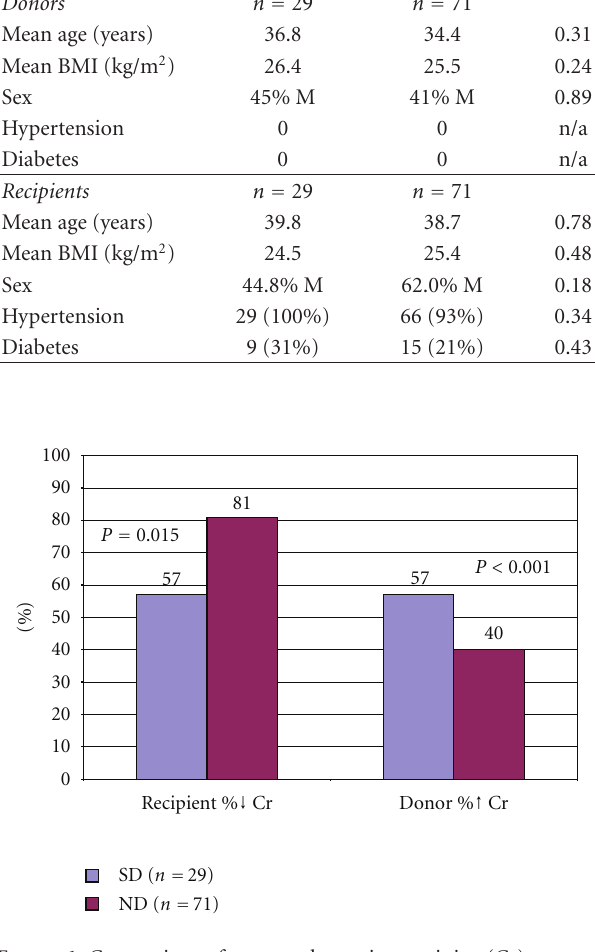
(Figure 2). Comparing calculated GFR values between the recipient groups revealed that SD-R’s had significantly lower GFR’s at 1 year (44.1 versus 54.7 mL/min per 1.73 m 2 , respec- tively; P = 0 . 018) and at most recent followup (37.0 versus 53.0 mL/min per 1.73 m 2 , resp.; P < 0 . 001; Table 2, Figure